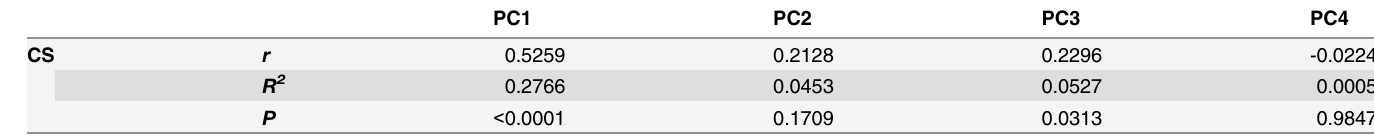
Table 4. Results of the correlation ( r ) and regression ( R 2 , P ) analysis between the PC scores and log centroid size (CS).